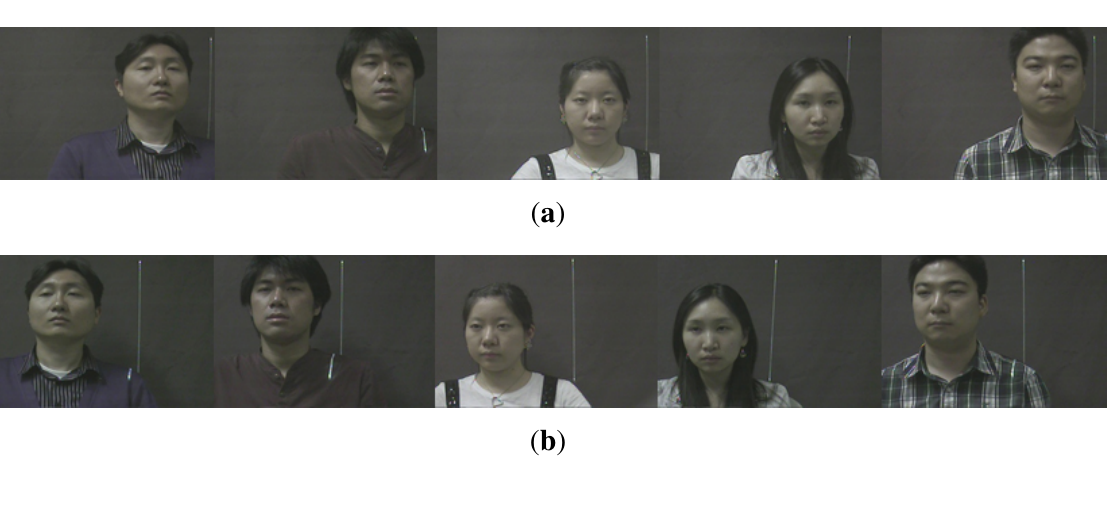
Figure 18. 3D face data used for random-profile-based 3D face recognition: ( a ) FD 3D face data as the gallery; and ( b ) partial random profile data as the